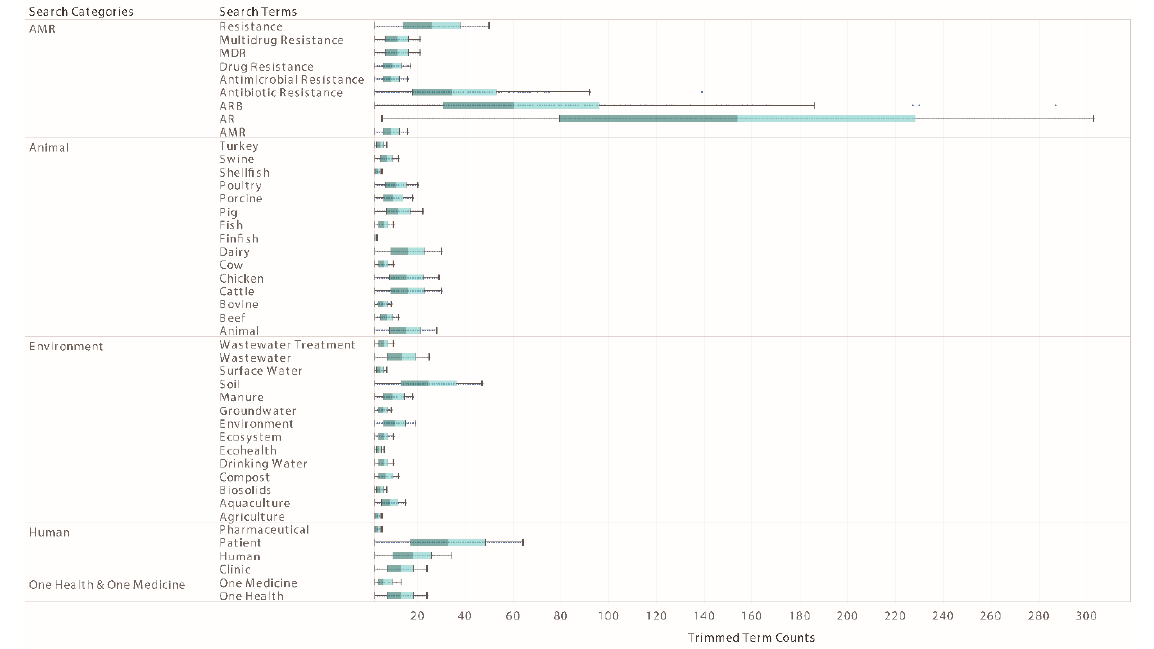
Figure 4. Box and whiskers of the top and bottom term counts in each of the term bins.